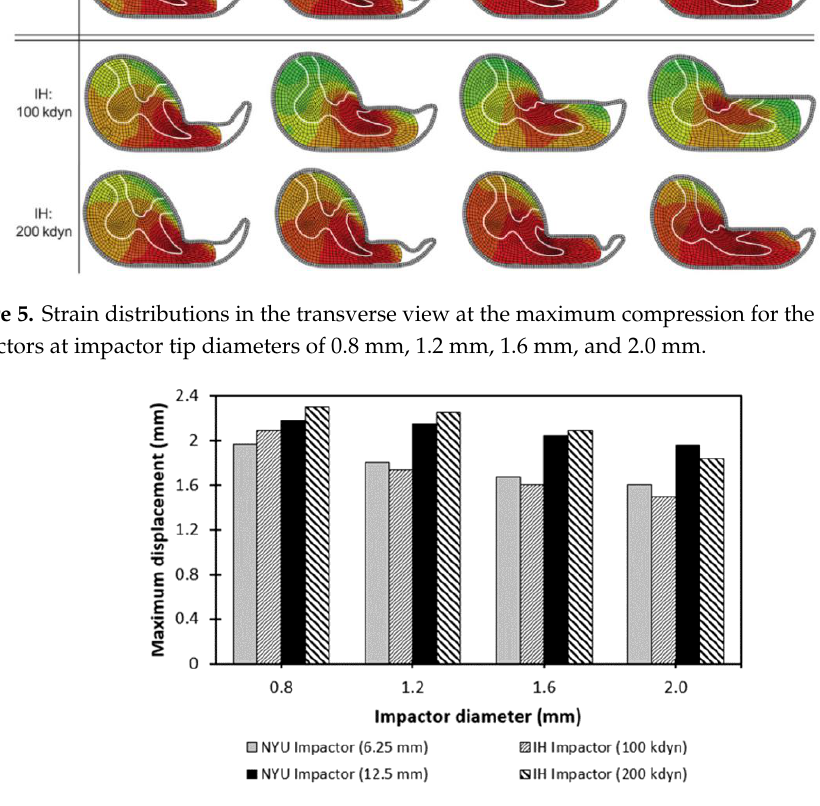
Figure 6. The maximum displacement of the spinal cord for the NYU and IH impactors at impactor tip diameters of 0.8 mm, 1.2 mm, 1.6 mm, and 2.0 mm. diameters of 0.8 mm, 1.2 mm, 1.6 mm, and 2.0